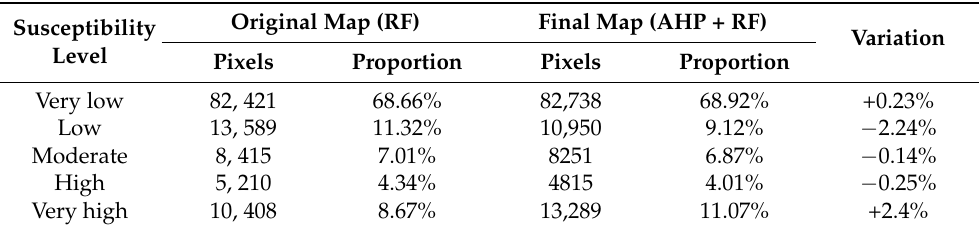
Table 7. Statistical analysis of the proportion of each susceptibility